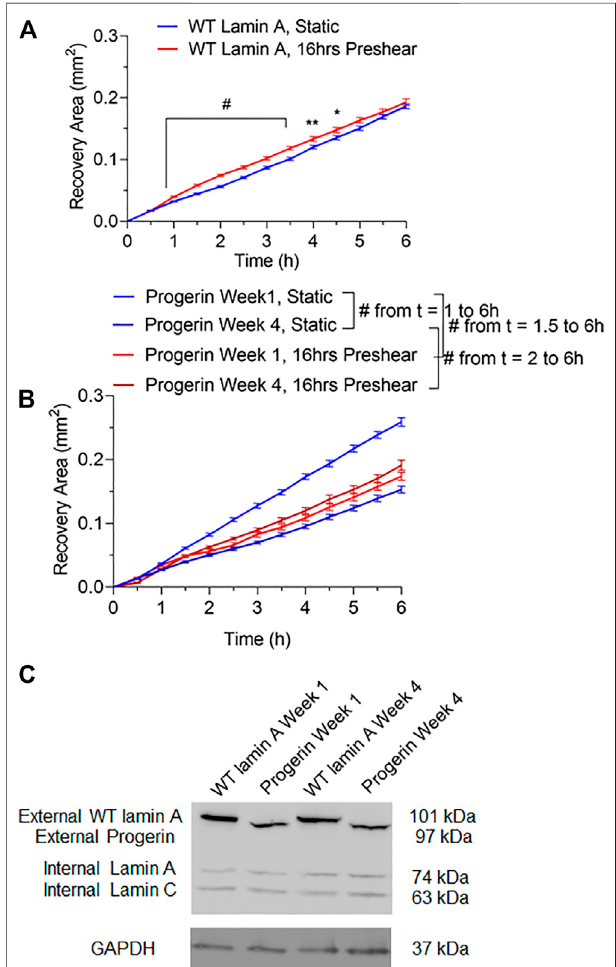
FIGURE3| Quanti fi cations ofwoundedareacovered bycellsduring the 6-h window after wound formation in wild-type lamin A-expressing ECs (A) and progerin-expressing ECs (B) . Blue lines represent the recovery area of cells that were under static state before wound formation over time, and red lines represent that of cells that underwent 16-h pre-shearing before wounds were created. * p < 0.05, ** p < 0.01, # p < 0.001. (C) Representative Western blot showed external protein expression levels in transduced ECs over serial